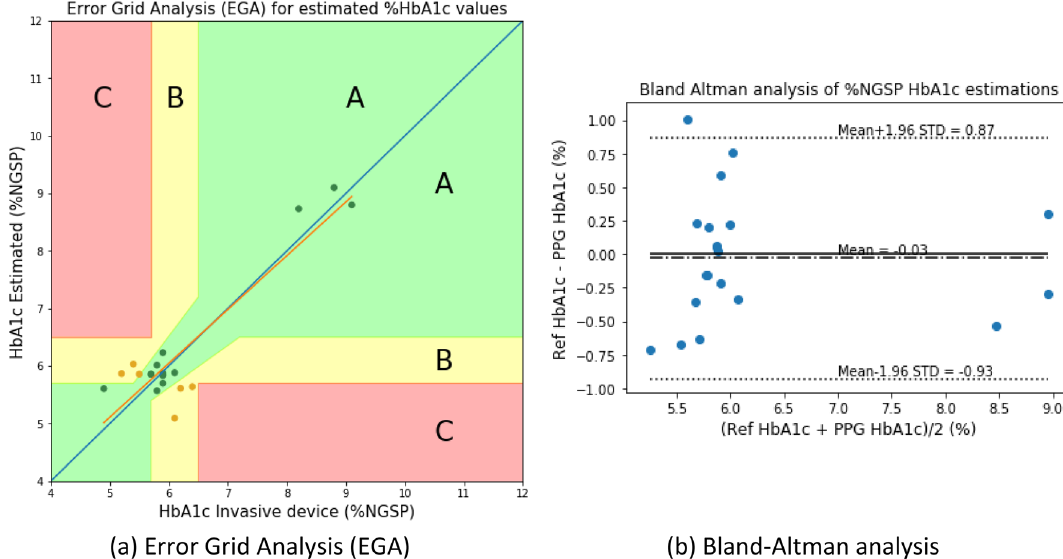
Figure 10. HbA1c Clarke’s error grid analysis (EGA) and Bland–Altman analysis for the blood-vessel model.